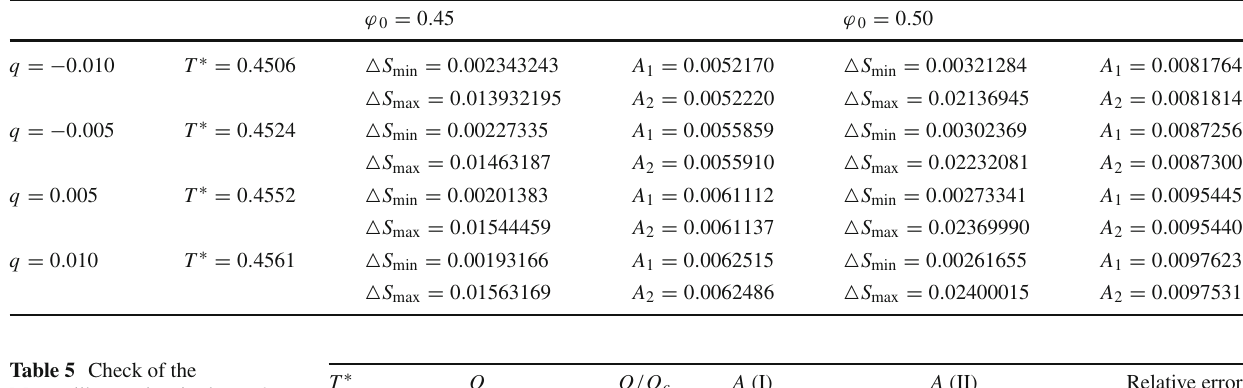
Table 5 Check of the Maxwell’s area law in the T – δ L plane for q = 0 . 010 and θ